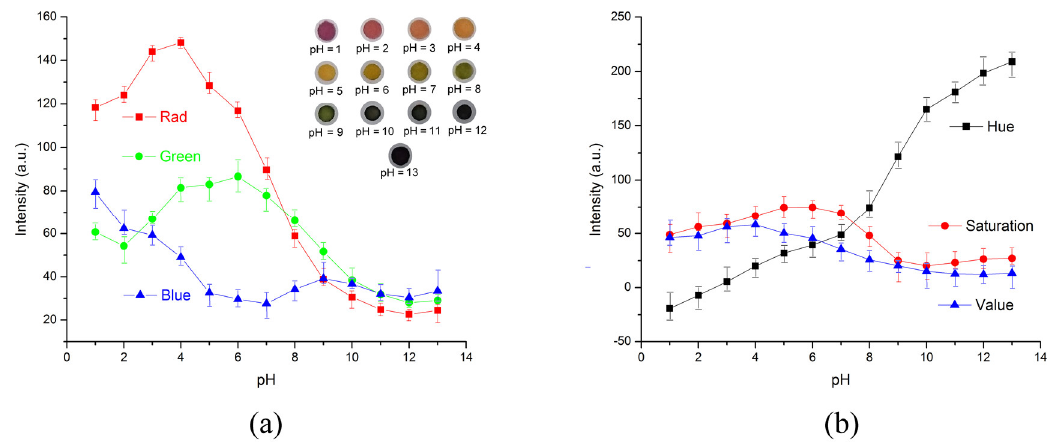
Figure 7. Intensities of pH test strips at each pH value in different color spaces. ( a ) RGB intensities of pH test strips at each pH value. None of the individual channel intensities correlate with the pH values in a monotonic function. Inserts are photos of testing strips taken by the smartphone. ( b ) Colors of pH test strips in HSV color space. The intensity of the H coordinate appears to be a monotonic function of the test strips’ chromaticity values. The presented experimental results are averaged from five tests.